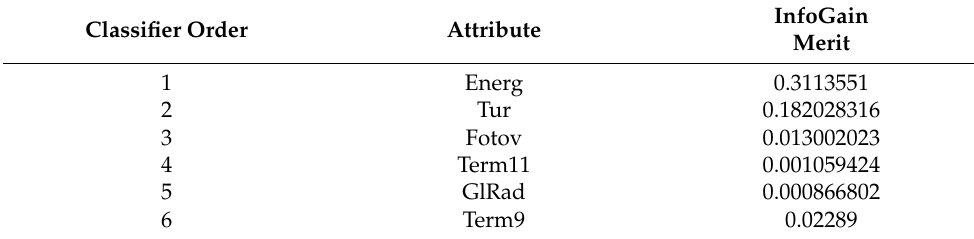
Table 10. Main attributes evaluator classifier attribute Jrip.